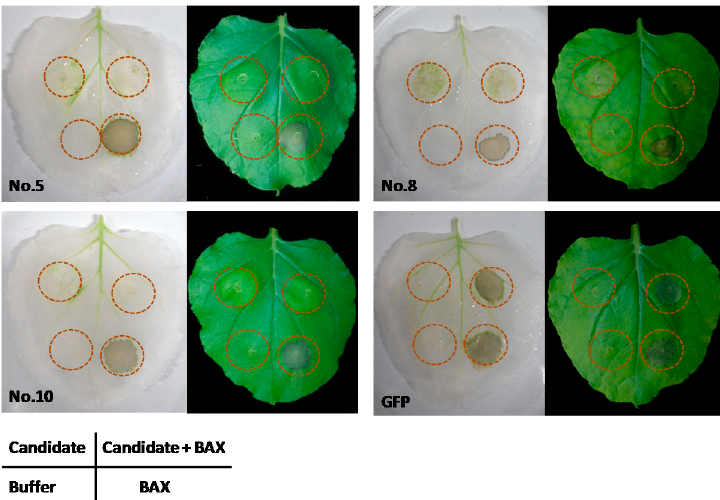
Figure 6. Expression of candidate genes that suppressed BAX-induced programmed cell death (PCD) in Nicotiana benthamiana . Four locations of selected leaves (illustrated in the table appended to the figure) were injected with the corresponding solutions. The pictures from the left panel were the leaves that had been boiled in 95% ethanol. No. 5, No. 8 and No. 10 putative proteins suppressed PCD triggered by pro-apoptosis protein BAX, and No. 8 protein also induced necrosis.